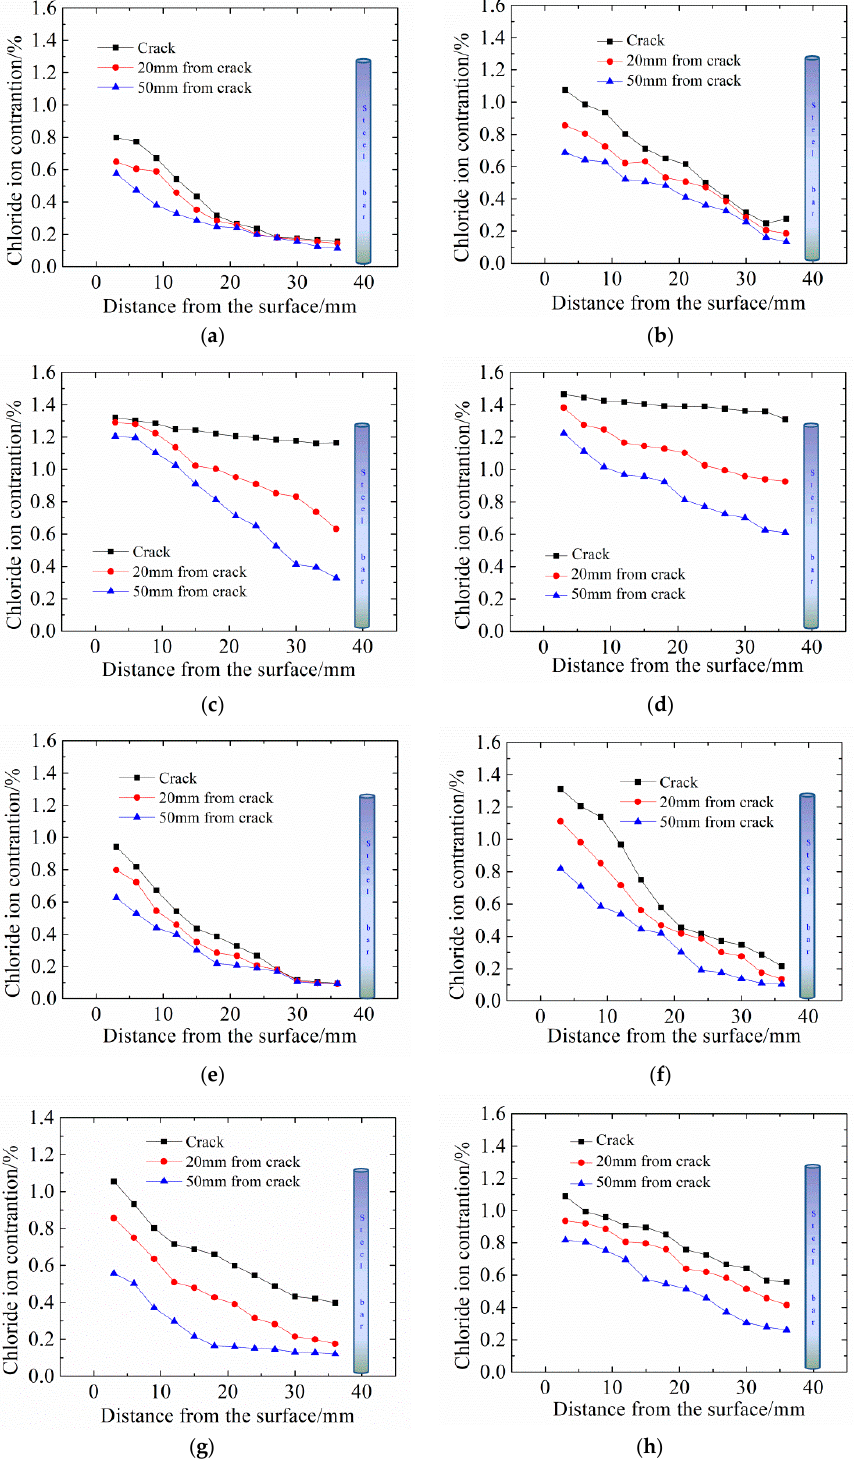
Figure 3. Chloride ion content distribution after electric acceleration. ( a ) Crack width (LC) = 0.10 mm; ( b ) Crack width (LC) = 0.15 mm; ( c ) Crack width (LC) = 0.20 mm; ( d ) Crack width (LC) = 0.30 mm; ( e ) Crack width (CR) = 0.10 mm; ( f ) Crack width (CR) = 0.15 mm; ( g ) Crack width (CR) = 0.20 mm; ( h ) Crack width (CR) = 0.30 mm.